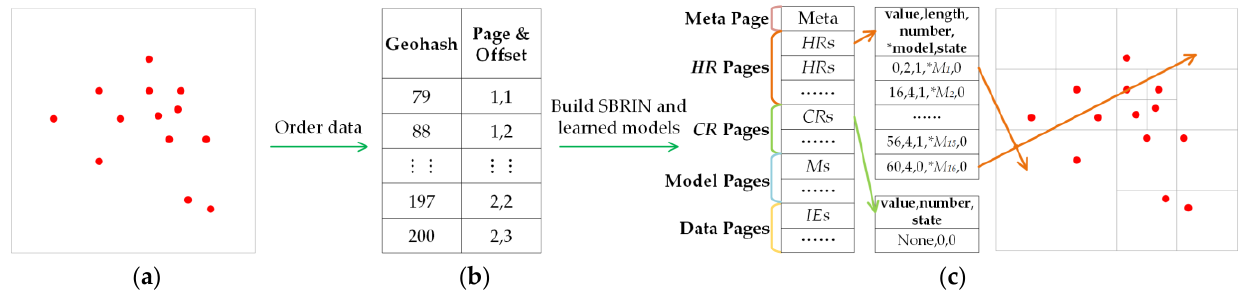
Figure 1. Build processing in SLBRIN. ( a ) Spatial dataset. ( b ) Index entries. ( c ) Structure of SLBRIN.